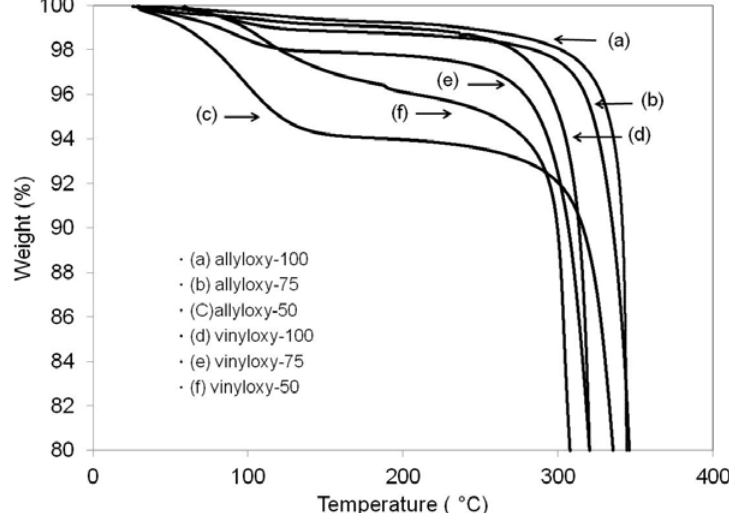
Figure 2. Thermal Gravimetric Analysis (TGA) analysis of cured hydrolyzable thiol-ene networks, with and without the addition of urethane oligomeric